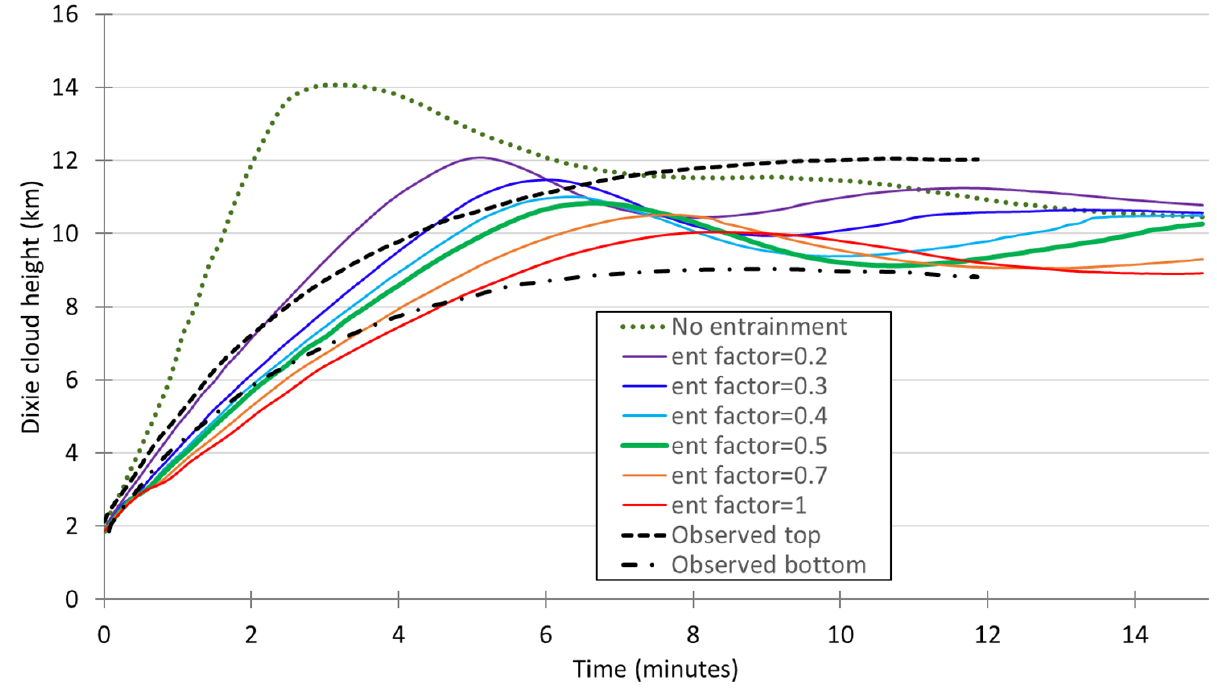
Figure 13. Dixie cloud rise dynamics for different entrainment factors. The black dashed profiles, green dotted profile, and colored solid profiles show the observed cloud top and bottom, the simulated cloud center without entrainment, and the simulated cloud center with varying f ent from 0.2 to 1, respectively.